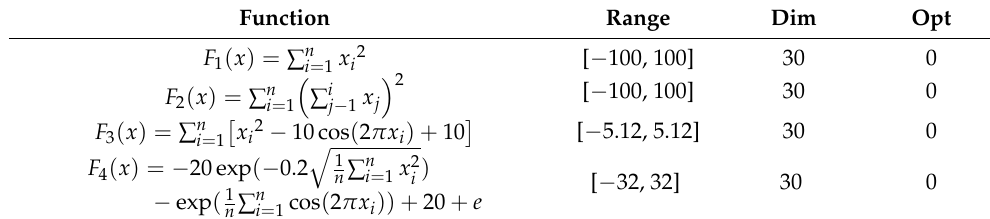
Table 1. Details of the test functions.